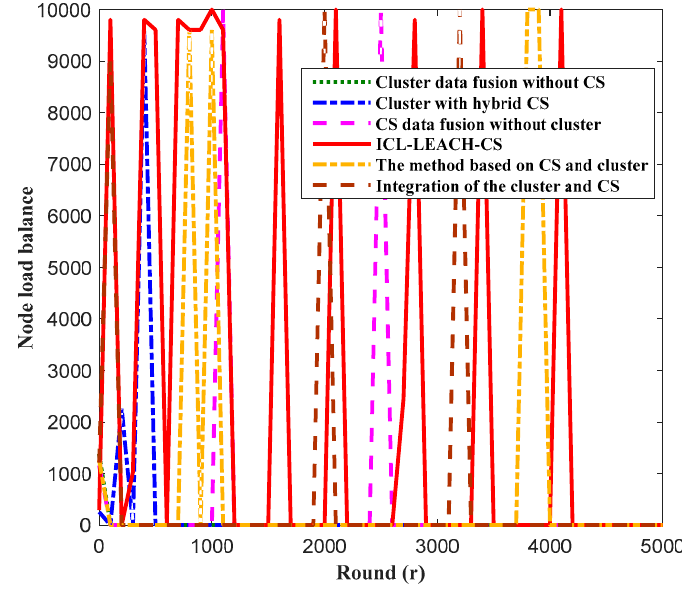
Figure 16. Node load balancevs. round.